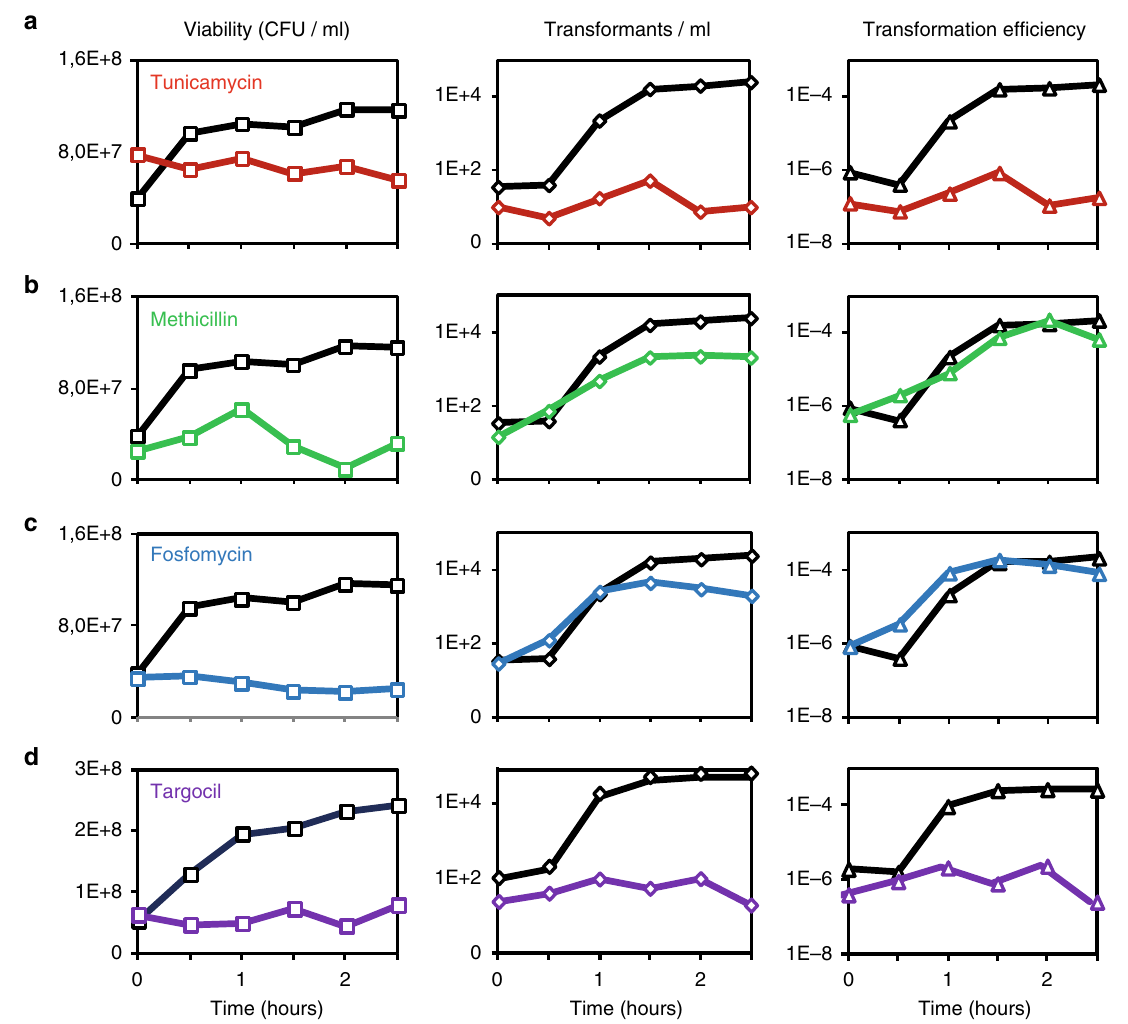
Fig. 1 Effect of cell wall-targeting antibiotics on genetic transformation. For details of the experimental procedure, see Supplementary Fig. 1. When B. subtilis cells (wild-type strain 168 in panels a , b , c and strain NC288 ( Δ tagGH Bs , amyE ::P hyperspank - tarGH Sa ) in panel d ) reached stationary phase in SPI medium (T 0 in Fig. 1 and Supplementary Fig. 1), we diluted the culture in SPII medium. Expression of tarGH genes (NC288) was induced by addition of 1 mM IPTG, supplemented in SPI and SPII. Drugs were added (color lines), or not (black lines), at T 0 . We used tunicamycin (a, red, 5 µ g/ml), methicillin ( b , green, 0.1 µ g/ml), fosfomycin ( c , blue, 320 µ g/ml) and targocil ( d , purple, 275 µ g/ml). Viability and the number of transformants per ml were evaluated every 30 min by plating on the adequate selective media. Transformation ef fi ciencies were calculated by dividing the number of transformants/ml by the viability at